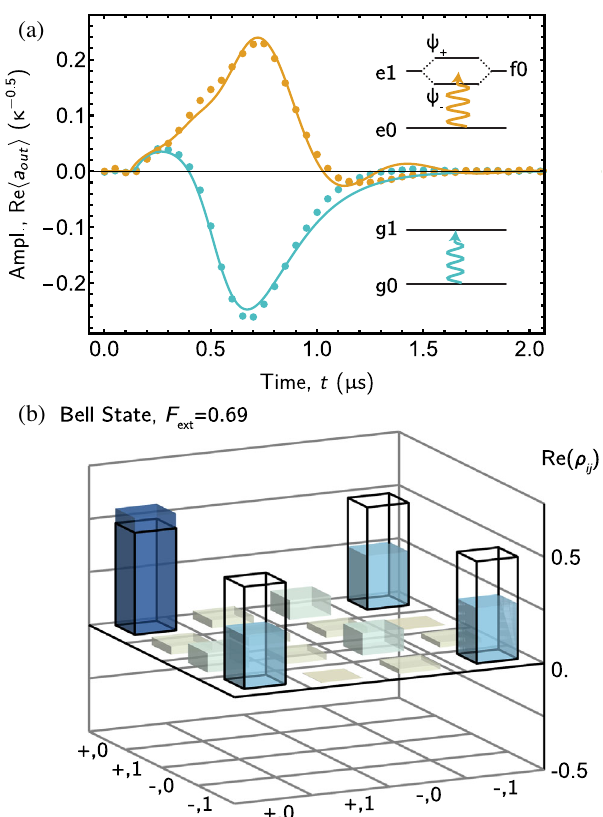
FIG. 3. (a) Measured (dots) and simulated (lines) real part of i for the states jþi emitted the envelope of the amplitude h a out from the source qubit and reflected off of the gate qubit while driving the j f 0 i ↔ j e 1 i transition of the gate qubit. Level diagrams and traces are shown for the gate qubit in the ground state (turquoise) and in the excited state (orange). The imaginary ffiffiffi p κ part (not shown) is below 0 . 04 = in magnitude. (b) Real part of the measured density matrix ρ (solid bars) and the ideal meas ¼ j ψ ih ψ j (black wire frames) of the two- density matrix ρ ffiffiffi p ideal 2 mode Bell state j ψ i ¼ ðjþ ; 0 i þ j − ; 1 iÞ = . The fidelity is j ψ i ¼ 0 . 69 . Imaginary parts (not shown) are all F ¼ h ψ j ρ meas below 0.04 in